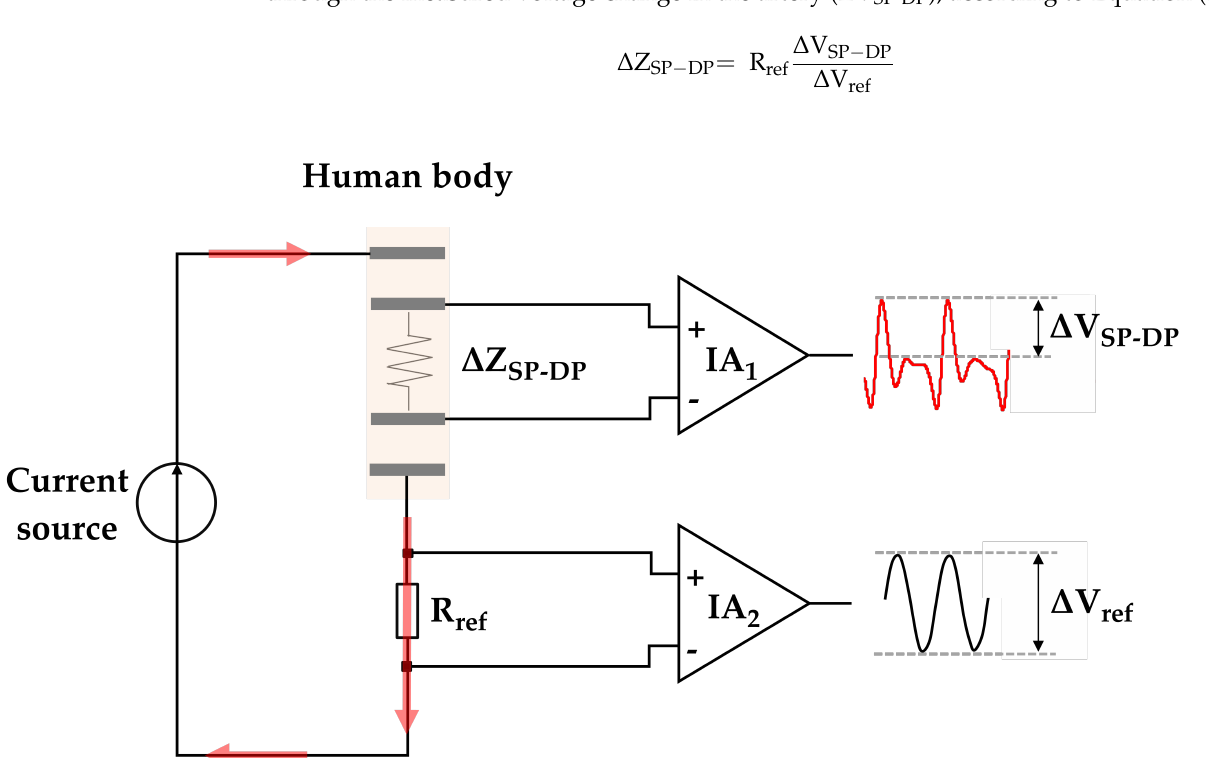
Figure 4. Schematic of the bio-impedance calculation method for the carotid